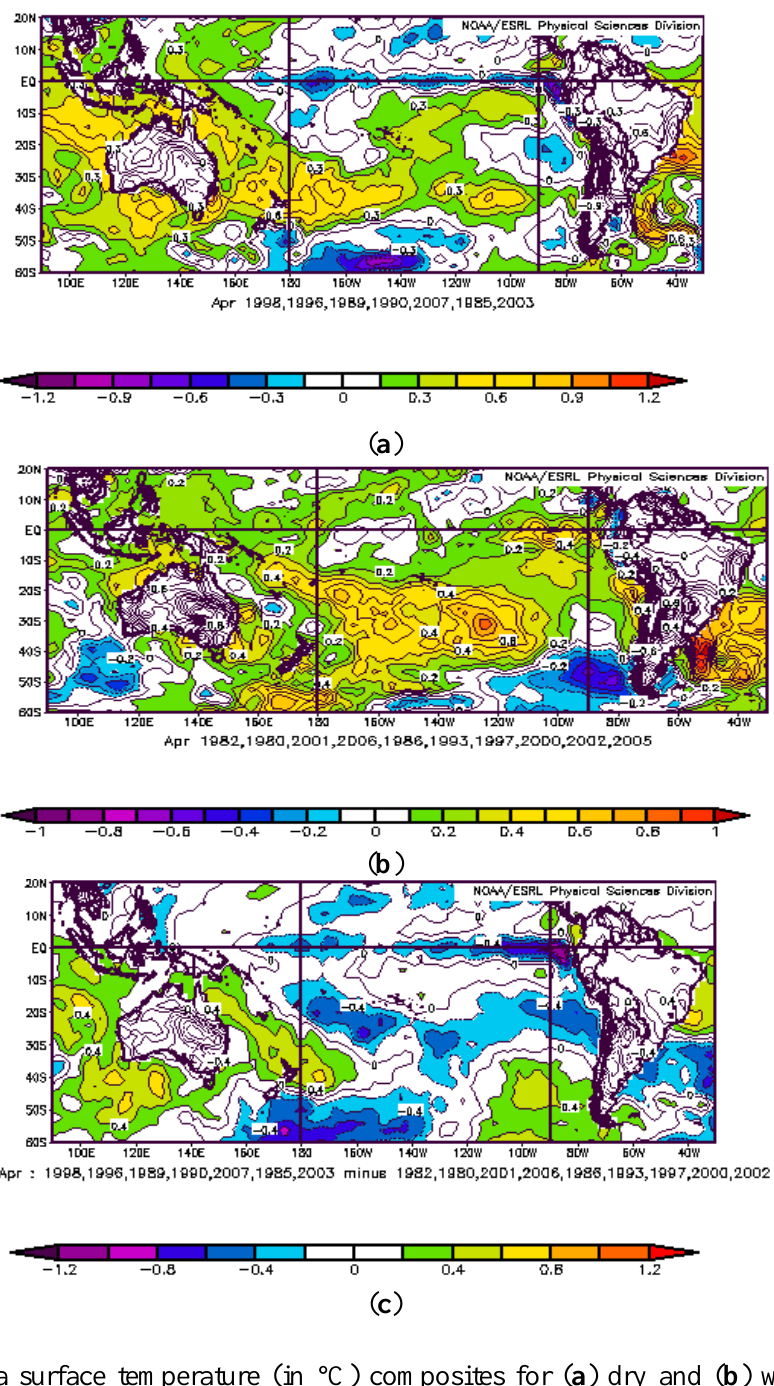
Figure 8. Sea surface temperature (in °C) composites for ( a ) dry and ( b ) wet cases and ( c ) the difference between them following the classification showed in Table